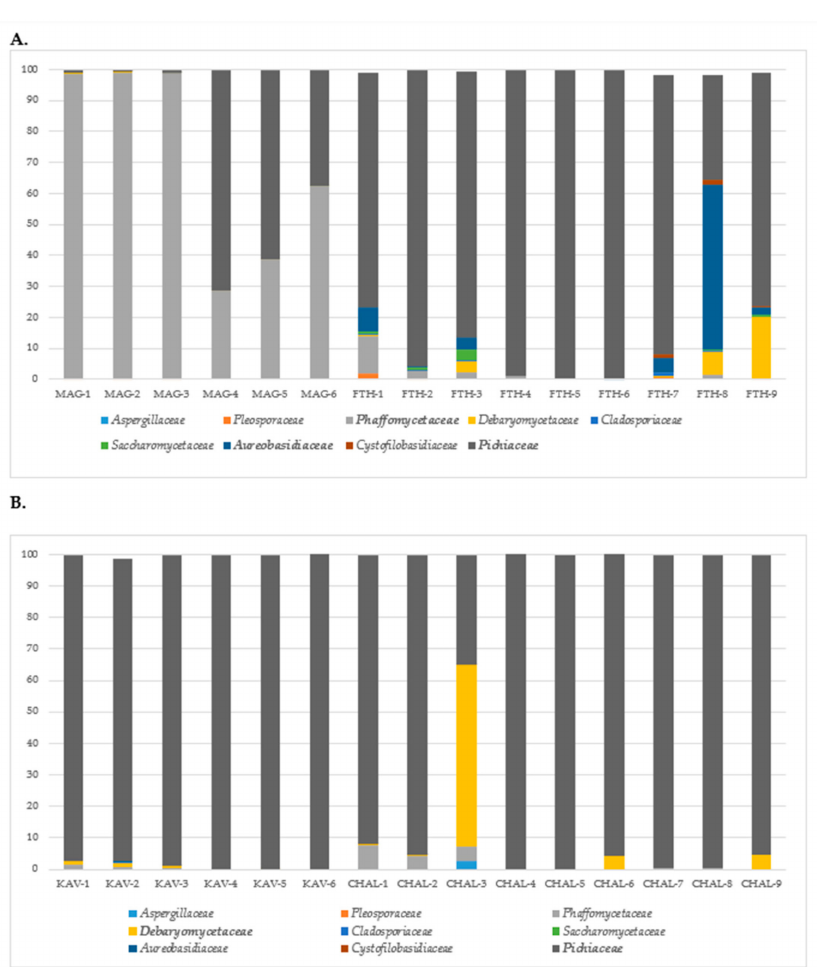
Figure 6. Relative abundance of total observed yeast families on table olives of ( A ) cv. Konservolia originating from the regions of Magnesia (MAG) and Fthiotida (FTH) and ( B ) cv. Halkidiki originating from the regions of Kavala (KAV) and Halkidiki (HAL). Only families above 1% occurrence are reported. Pichiaceae was mainly detected at highest relative abundance in green, Spanish-style fermented olives cv. Halkidiki from both geographical regions (Figure 6B) and the majority of olive samples cv. Konservolia (Figure 6A). In the case of Konservolia olives from Magnesia, Pha ff omycetaceae was the dominant family in four samples, followed by Pichiaceae that dominated in two samples,